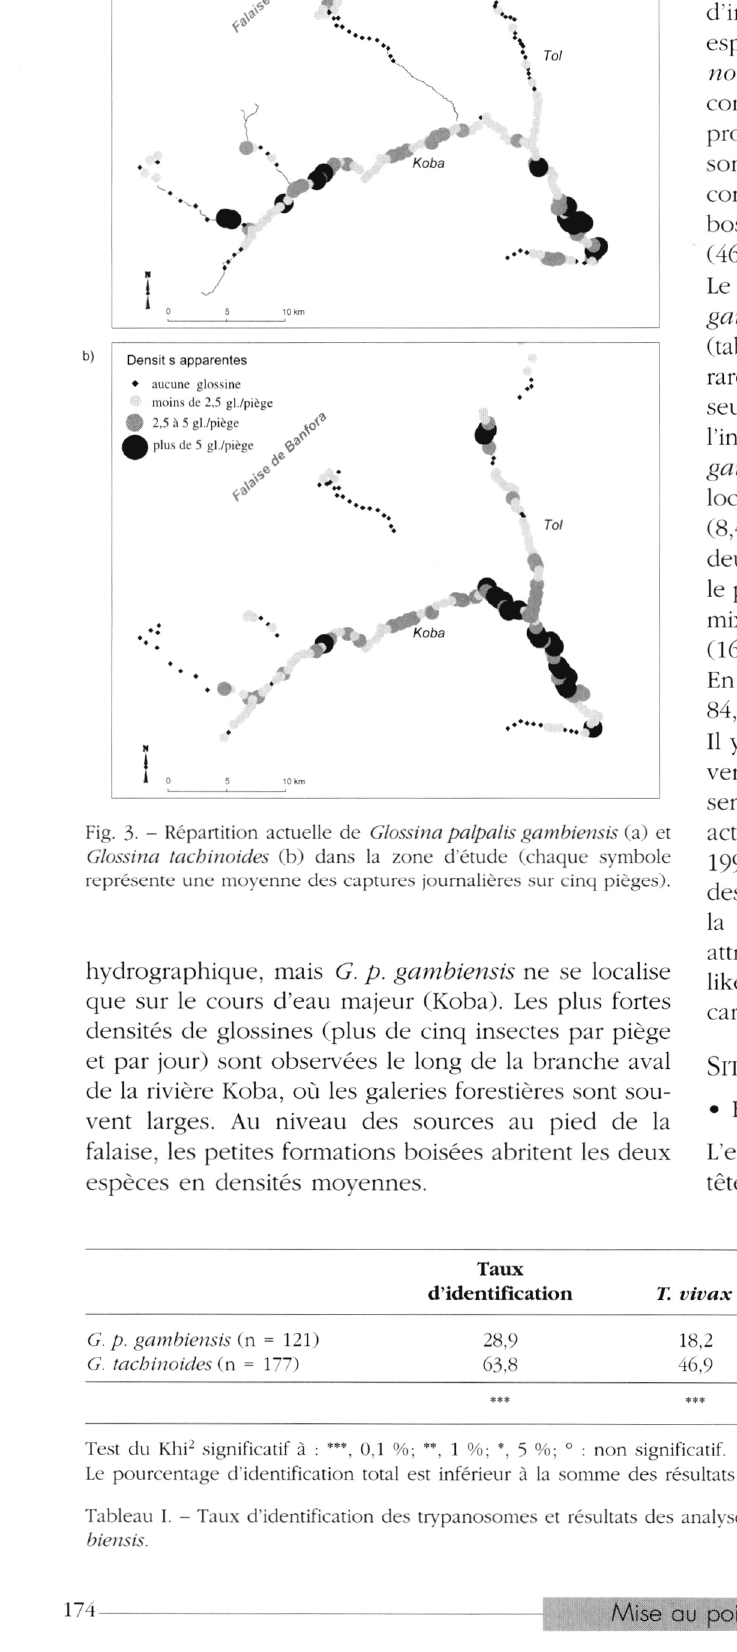
Tableau I. - Taux d’identification des trypanosomes et résultats des analyses par PCR (en pourcentage) chez G. tachinoides et G. p. Gam­ biensis